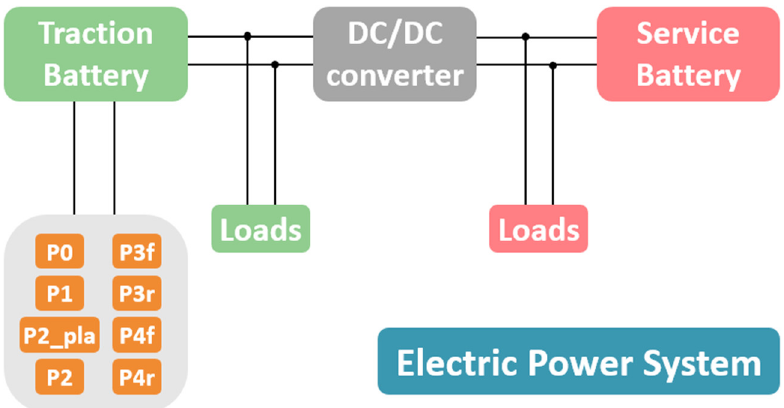
Figure 3. Generic Electric Power System model [22].